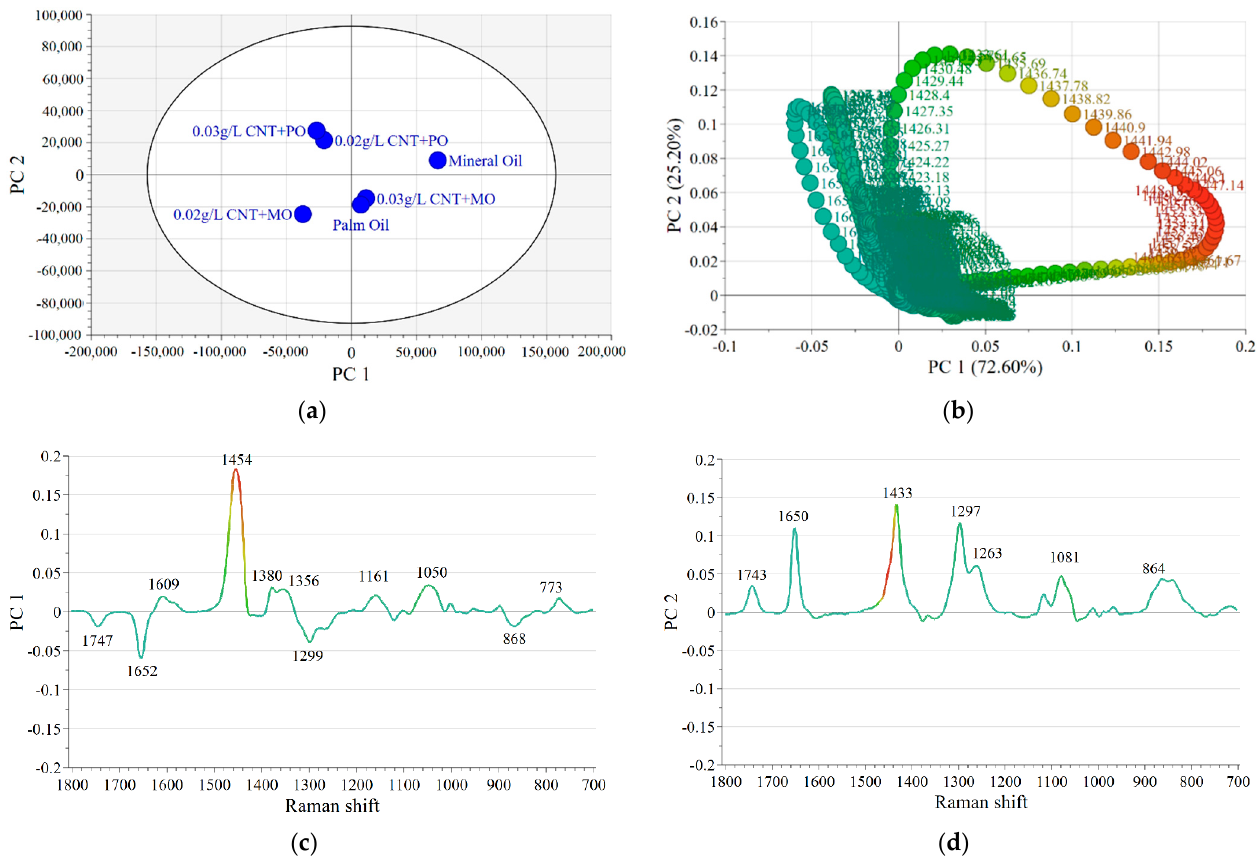
Figure 8. Principal component analysis model of the data set for six oil samples; ( a ) Score plot, ( b ) loadings scattered plot in PC1 and PC2, ( c ) loadings in PC1, ( d ) loading in PC2.